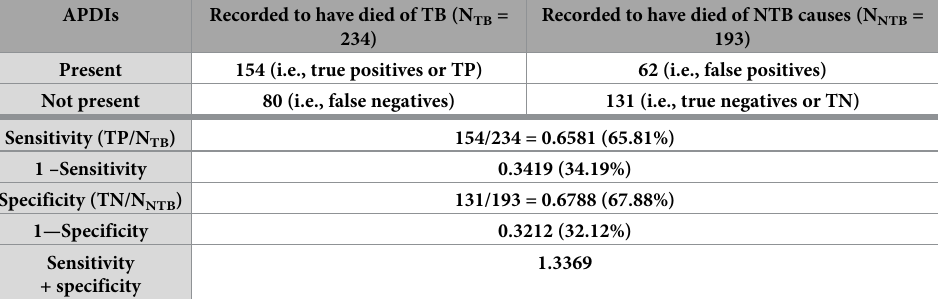
Table 4. Summary of the statistical results, considering the diagnostic sensitivity and specificity of